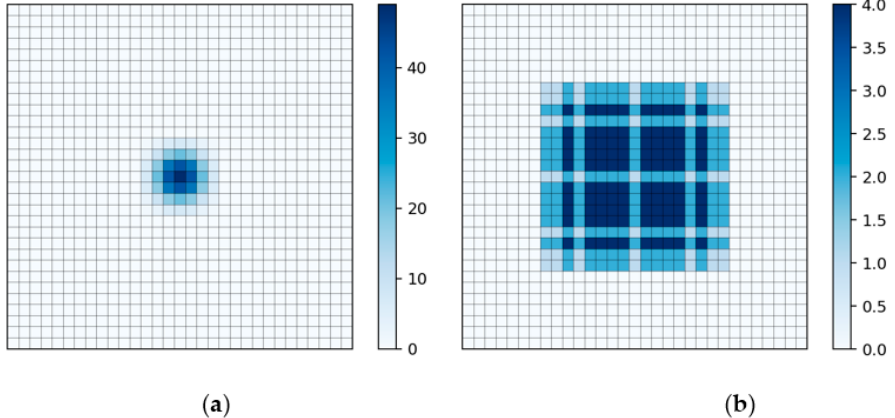
Figure 9. Comparison diagram of continuous convolution sampling. The color from light to dark indicates the number of pixel calculations from less to more. ( a ) The receptive field after three standard convolutions [1,1,1]; ( b ) the receptive field after the combination of dilated convolutions with expansion rates of [1,2,5].